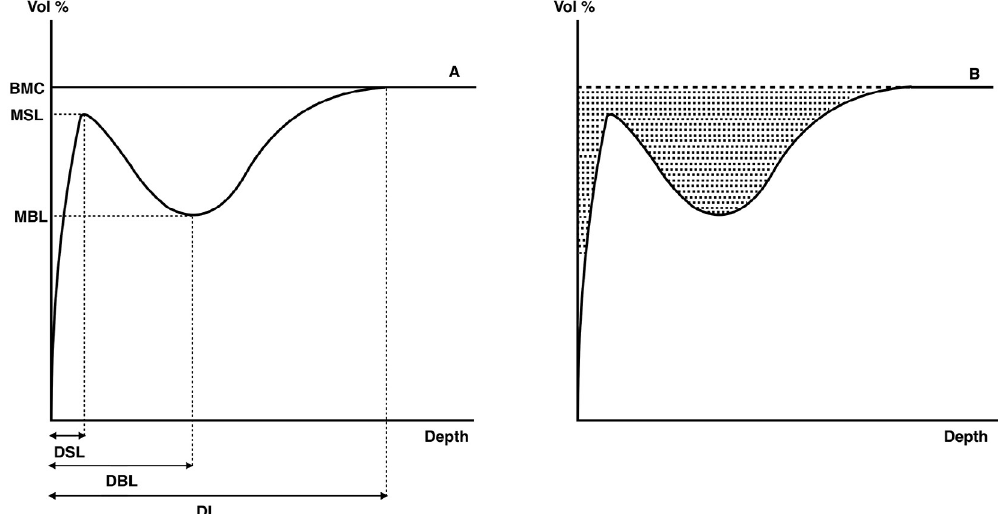
Figure 1- Schematic drawing of white spot lesion using transverse microradiography (based on Theuns, et al. 20 ). A) Lesion characteristics: BMC, basic mineral content; MSL, Maximum mineral content of the surface layer; DSL, depth at the point where maximum mineral content is reached; MBL, minimum mineral content of the body lesion; DBL, depth at the point where minimum mineral content is reached; and DL, the depth of the lesion; B) Dissolved minerals are presented as the shaded